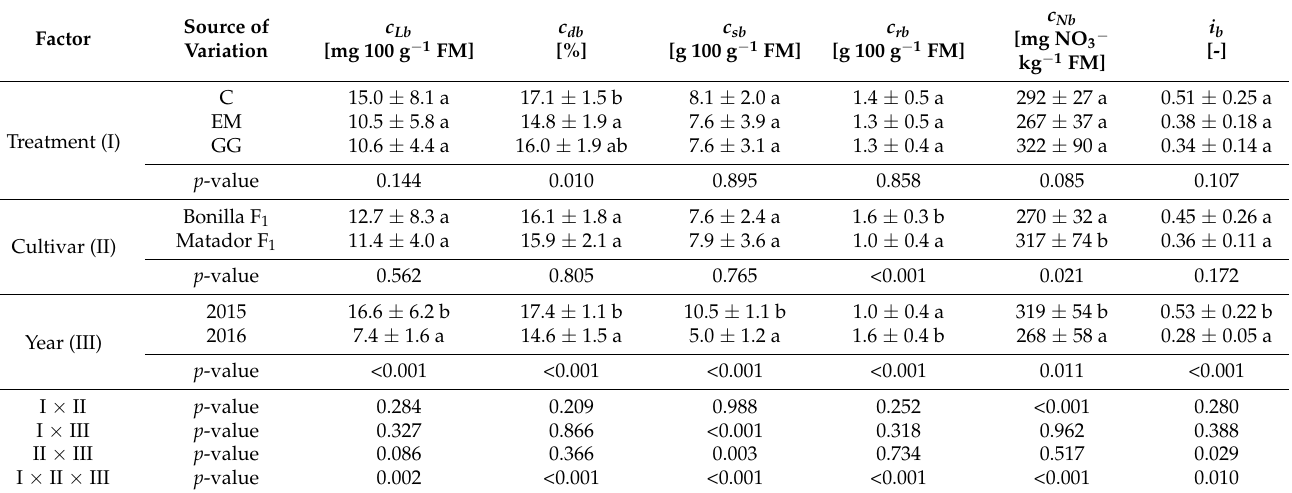
Table 4. Chemical composition of shallot